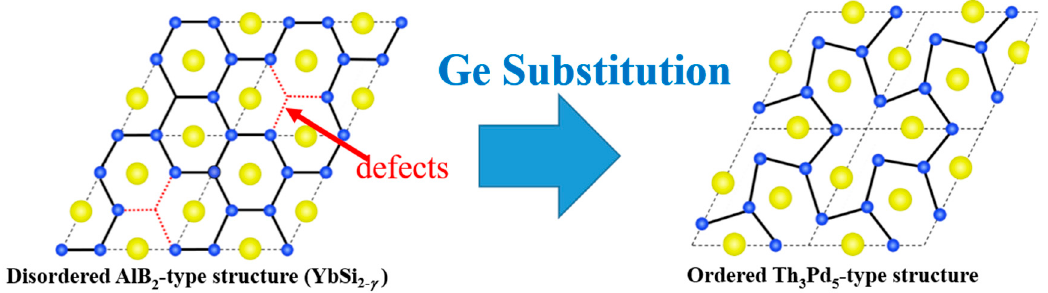
Figure 7. Schematic of crystal structure of YbSiGe projected along the c axis, showing a structural transition from the disordered AlB 2 -type structure to the ordered Th 3 Pd 5 -type structure. Yellow and blue balls represent Yb and Si / Ge, respectively. Reproduced with permission from Ref. [36]. Copyright 2018, AIP